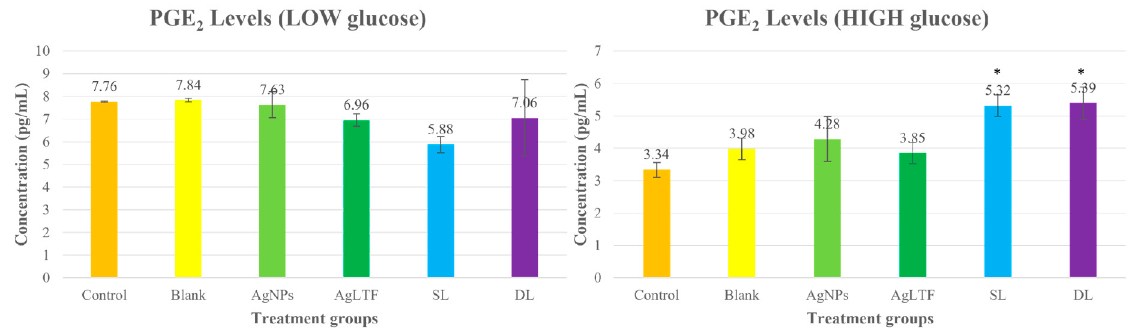
Figure 13. Measurements of PGE 2 of the control, blank, AgNPs, AgLTF, SL, and DL in high and low glucose culture medium using the ELISA technique, n = 5. * statistically significant different from the positive control of their respective culture medium groups ( p < 0.05).